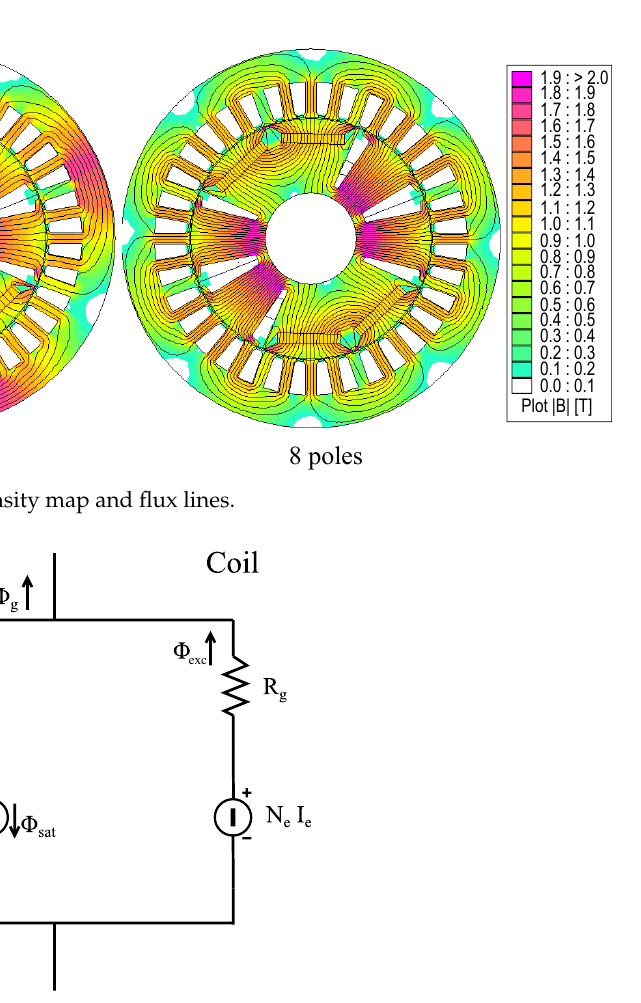
Table 2. Rotor data